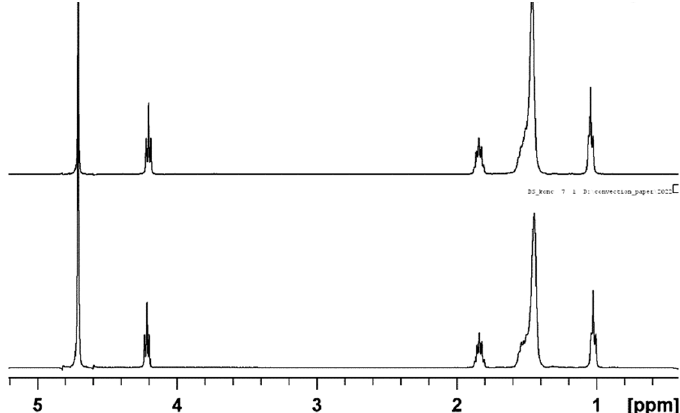
Figure 1. 1 H NMR spectra of sodium decyl-sulfate (NaDS) below cmc (5 × 10 − 3 mol kg − 1 , upper spectrum) and above cmc (5.6 × 10 − 2 mol kg − 1 , lower spectrum). Peaks assignment: 4.71 ppm HDO, 4.22 ppm CH 2 (1), 1.84 ppm CH 2 (2), 1.4–1.6 ppm CH 2 (3–9) and 1.03 ppm CH 3 .